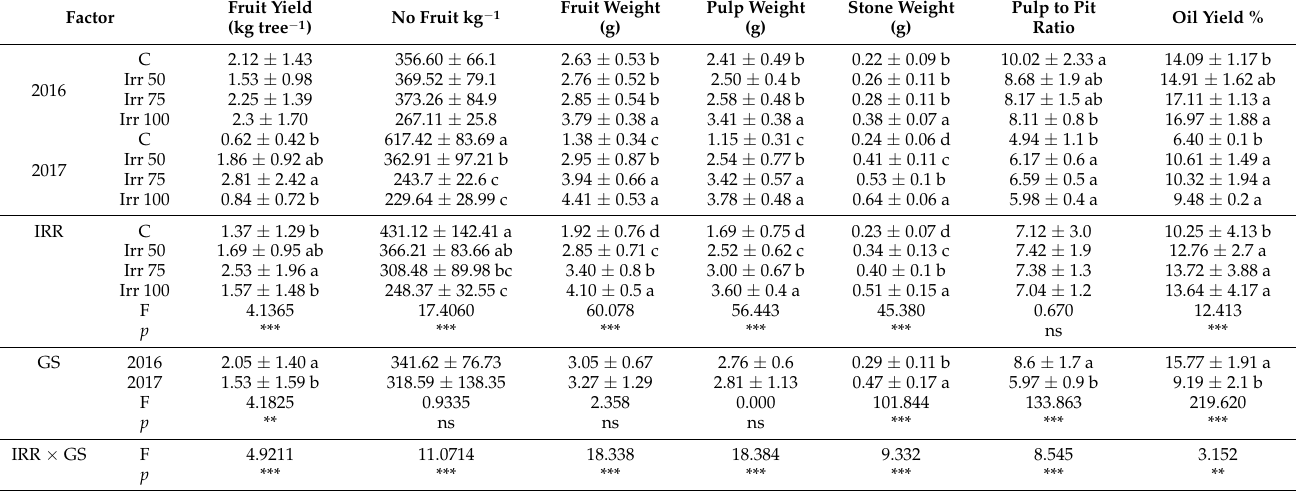
Table 4. Effect of different irrigation levels on fruit yield, number of fruits per kilogram, fruit and stone weight, pulp to pit ration and oil yield in two experimental